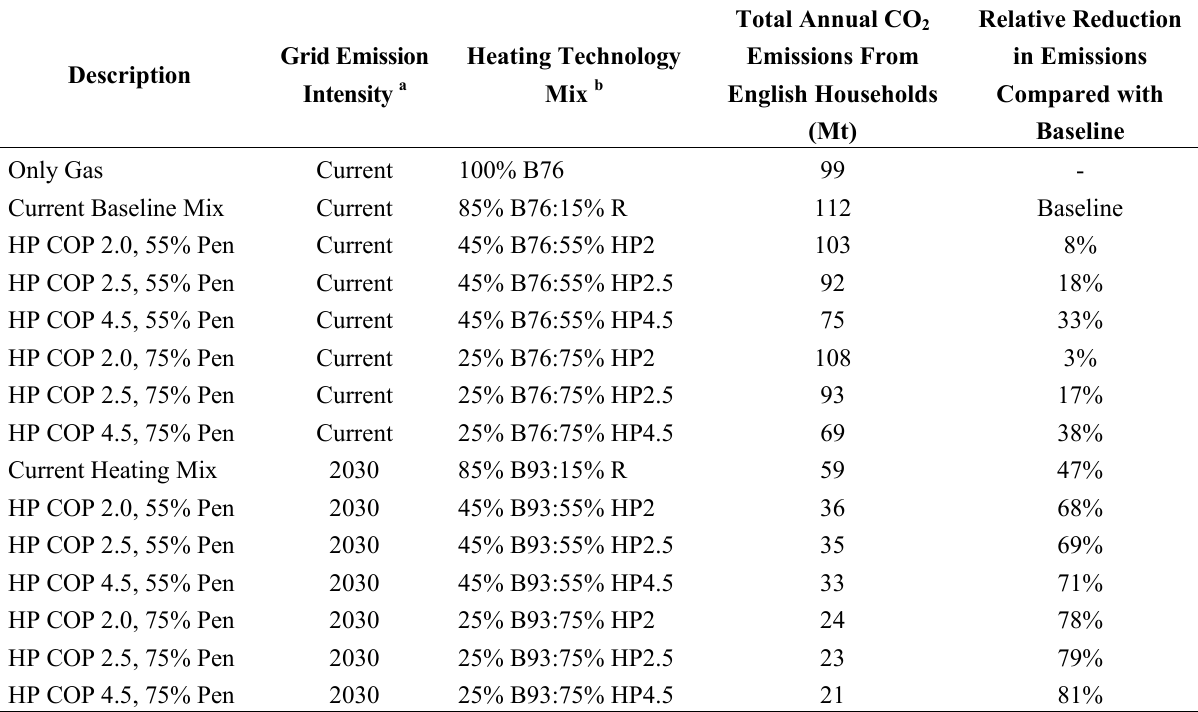
Table 7. Total estimated English household CO performance and penetration levels at current and aspirational electricity grid emission